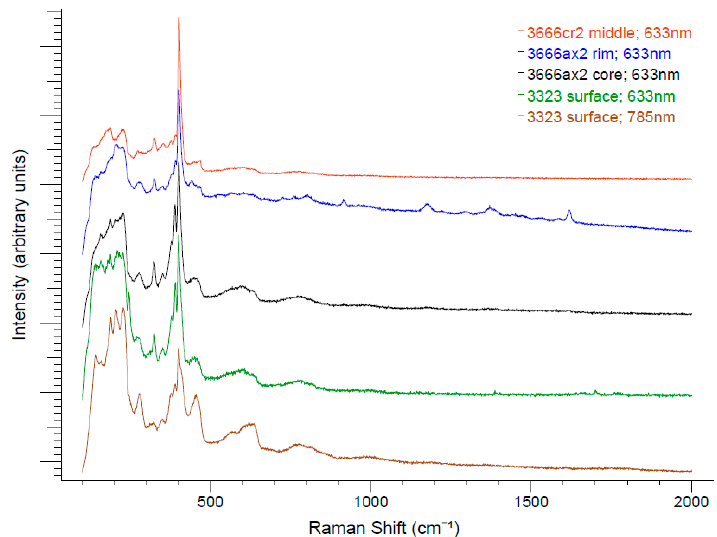
Figure 8. Representative Raman spectra, independently scaled and vertically shifted for clarity, from the surface of sample 3323, and from polished samples 3666ax2 and 3666cr2 using 633-nm and 785-nm incident radiation. The “3666cr2 middle” spectrum was taken from a region of the cross section shown in Figure 7 midway between the center and the surface. Spectra “3666ax2 rim” and “3666ax2 core” were taken from the longitudinal section of the whisker shown in Figure 6 from regions between the axis and the surface (rim), and from the brightly reflecting core, respectively.